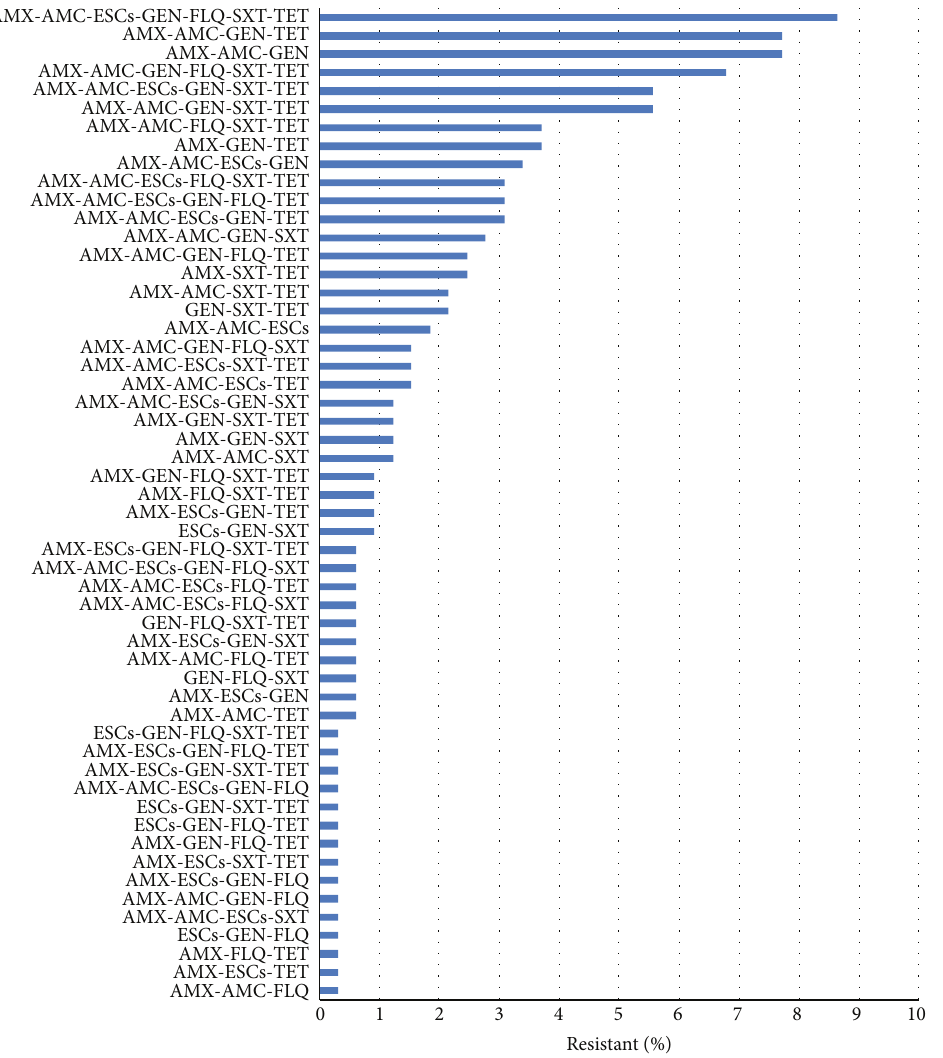
2007, 26 in 2008, 105 in 2009, 63 in 2010, 92 in 2011,